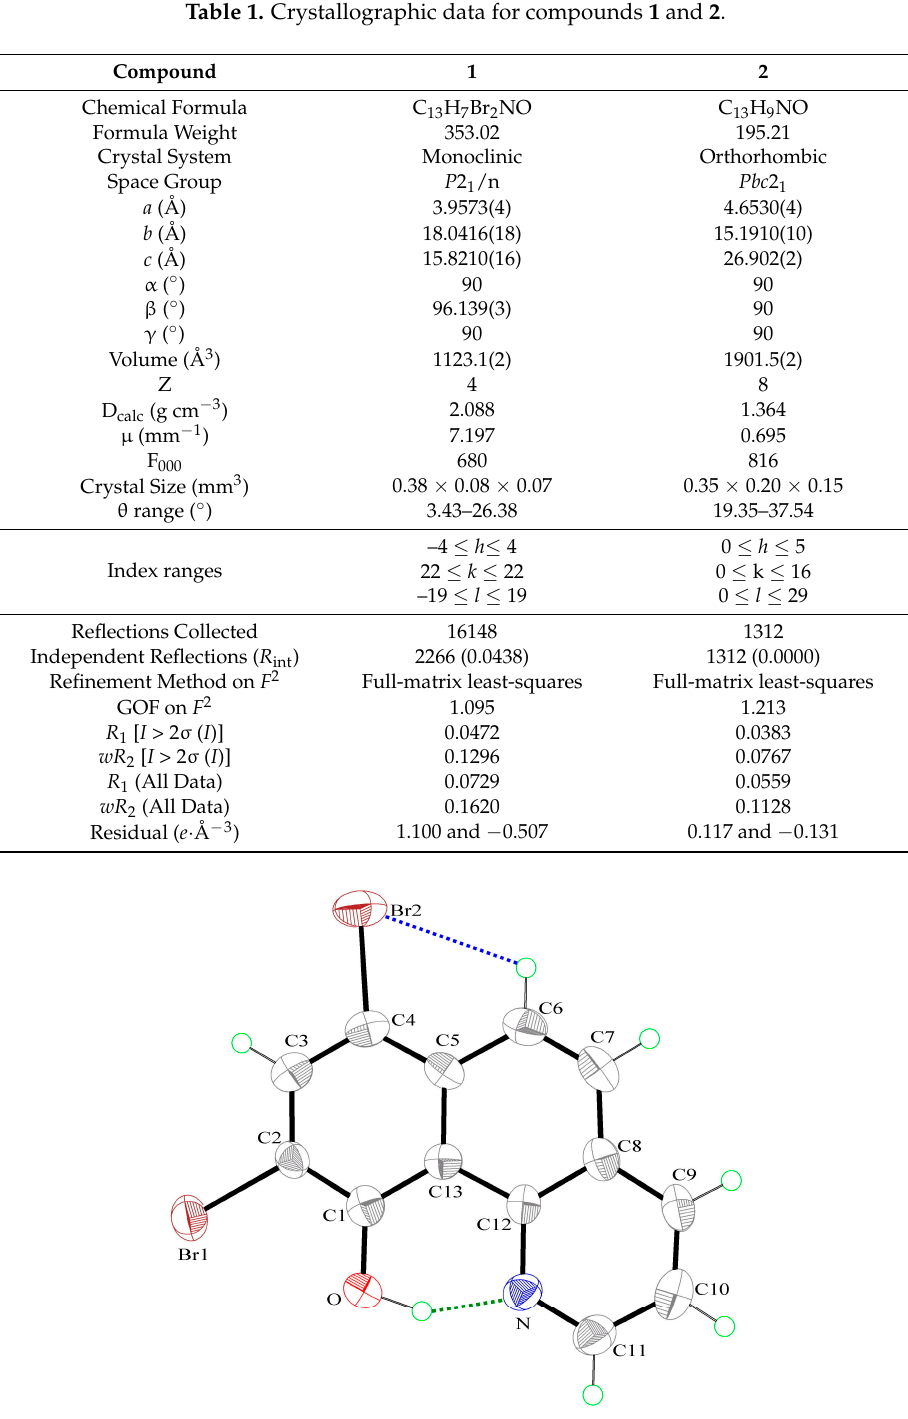
Figure 1. The molecular structure of 1 , showing the atom-labeling scheme. Displacement ellipsoids are drawn at the 50% probability level. Green and blue dashed lines denote the intramolecular O–H · · · N and C–H · · · Br hydrogen bonds. Table 1. Crystallographic data for compounds 1 and 2 .